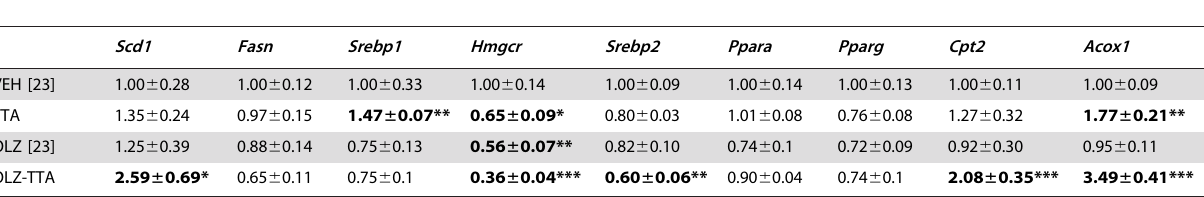
Data are given as fold change relative to vehicle, and presented as mean 6 SEM. Data shown are normalised to P0 (Arbp), with comparable results when normalised to b - actin. *P # 0.05 vs vehicle. **P # 0.01 vs vehicle. ***P # 0.001 vs vehicle. Subchronic data for the VEH, OLZ, and APZ groups have been reported in a previous article [23]. Gene abbreviations: Scd1 ; stearoyl-CoA desaturase. Fasn ; fatty acid synthase. Srebp1 ; sterol regulatory element binding protein 1, Srebp2 ; sterol regulatory element binding protein 2. Hmgcr ; 3-hydroxy-3- methylglutaryl-CoA reductase. Ppara : peroxisome proliferator activated receptor a , Pparg : peroxisome proliferator activated receptor c . Cpt2 : carnitine O- palmitoyltransferase 2. Acox1 : acyl-Coenzyme A oxidase